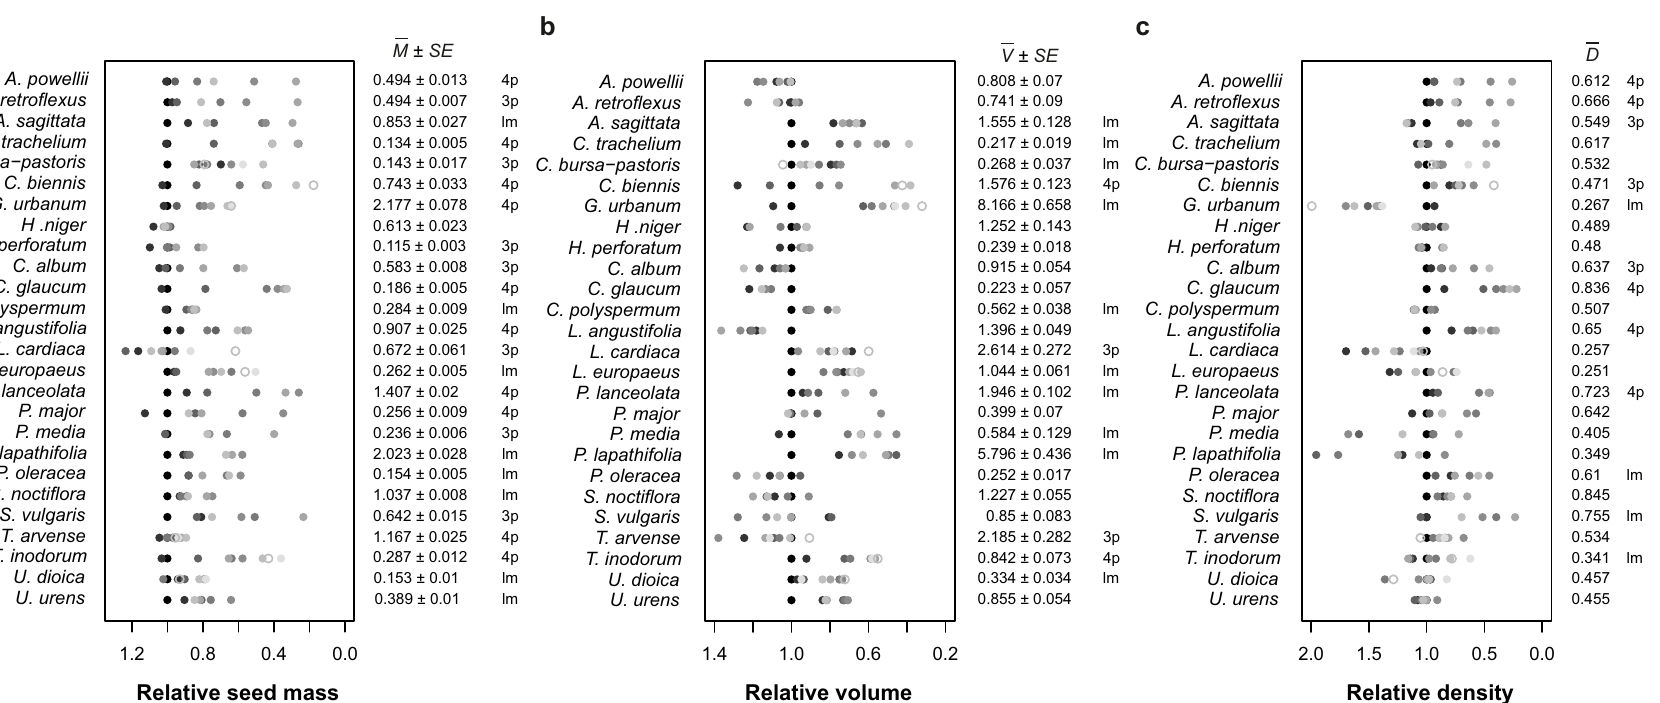
Figure 1. Variation in seed morphology with year after burial ( YAB ) for 26 species of seeds: ( a ) relative seed mass ( rM ); ( b ) seed volume ( rV ); ( c ) relative seed density ( rD ). The decrease in the intensity of grey colour refers to the increase in YAB : black = control, white with grey lining = YAB 8 are the two extremes). M ± SE and V ± SE denote the mean dry mass of control seeds ± standard error. D denotes the mean dry mass of control seeds. Lm (linear), 3p (3-parameter logistic) and 4p (4-parameter logistic) indicate the model that fitted the change in the seed trait over time based on the Akaike Information Criterion, if any of the three models were significant. See Table 1 for generic names of each